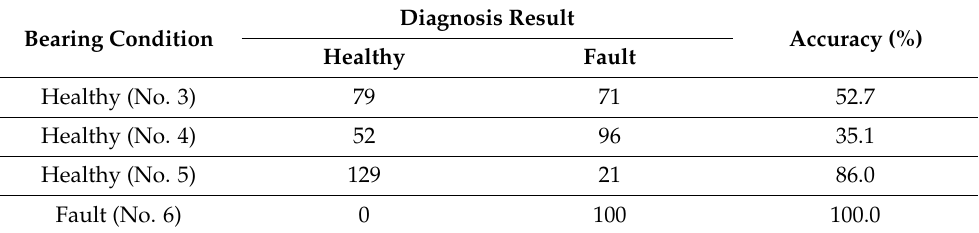
Table 5. Diagnosis result based on SVM.